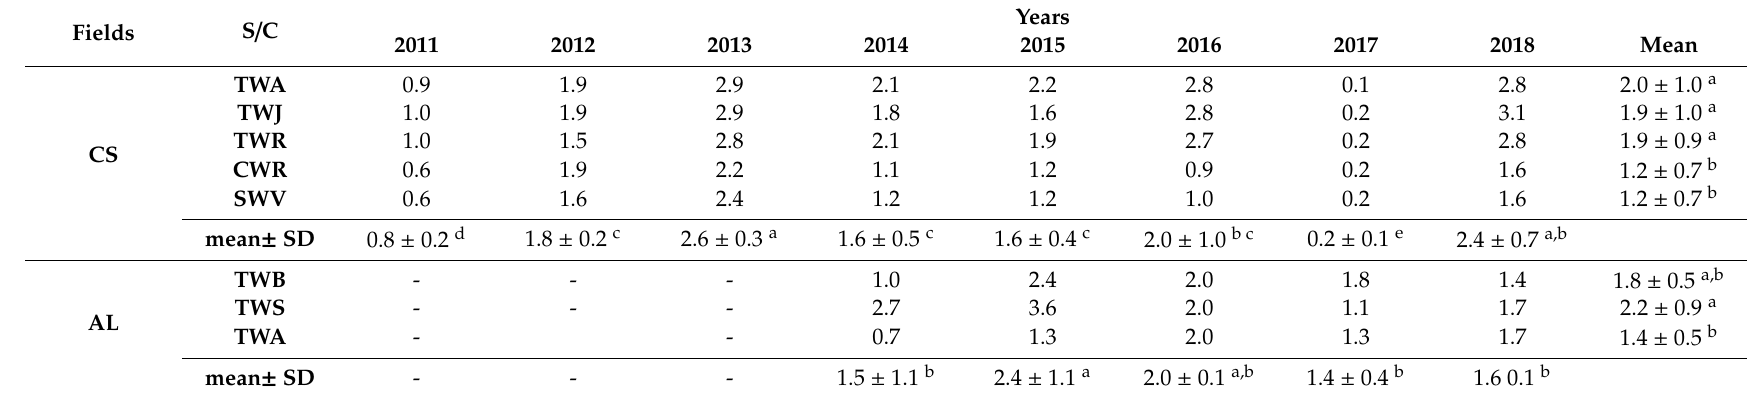
Table 4. RUE from CS and AL stations. Data provided in g DM · L − 1 .